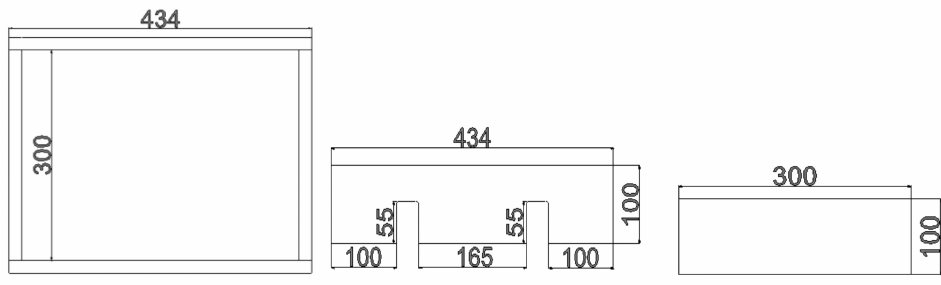
Figure 7. Detailed dimensions of specimen formwork (dimensions are in mm).